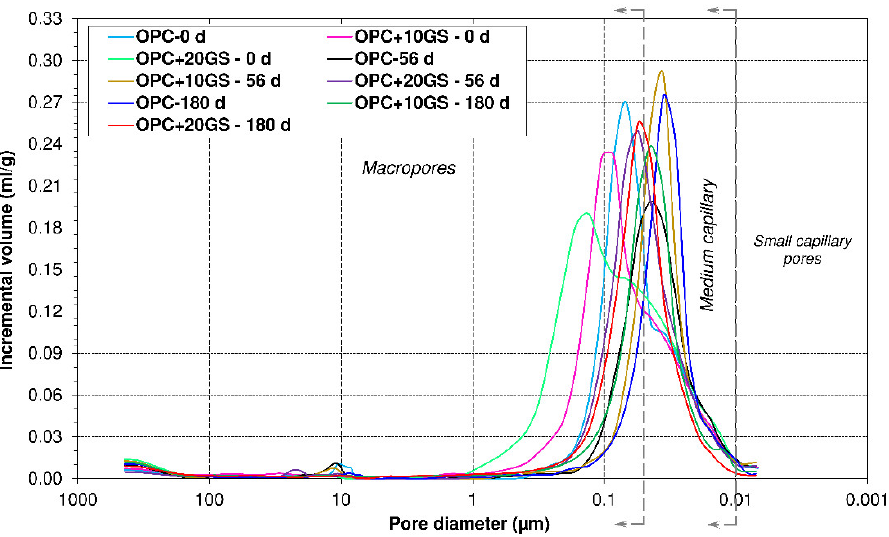
Figure 7. Variation in pore size diameter with time in pastes exposed to sulfates (t i = 0, 56 or 180 days).